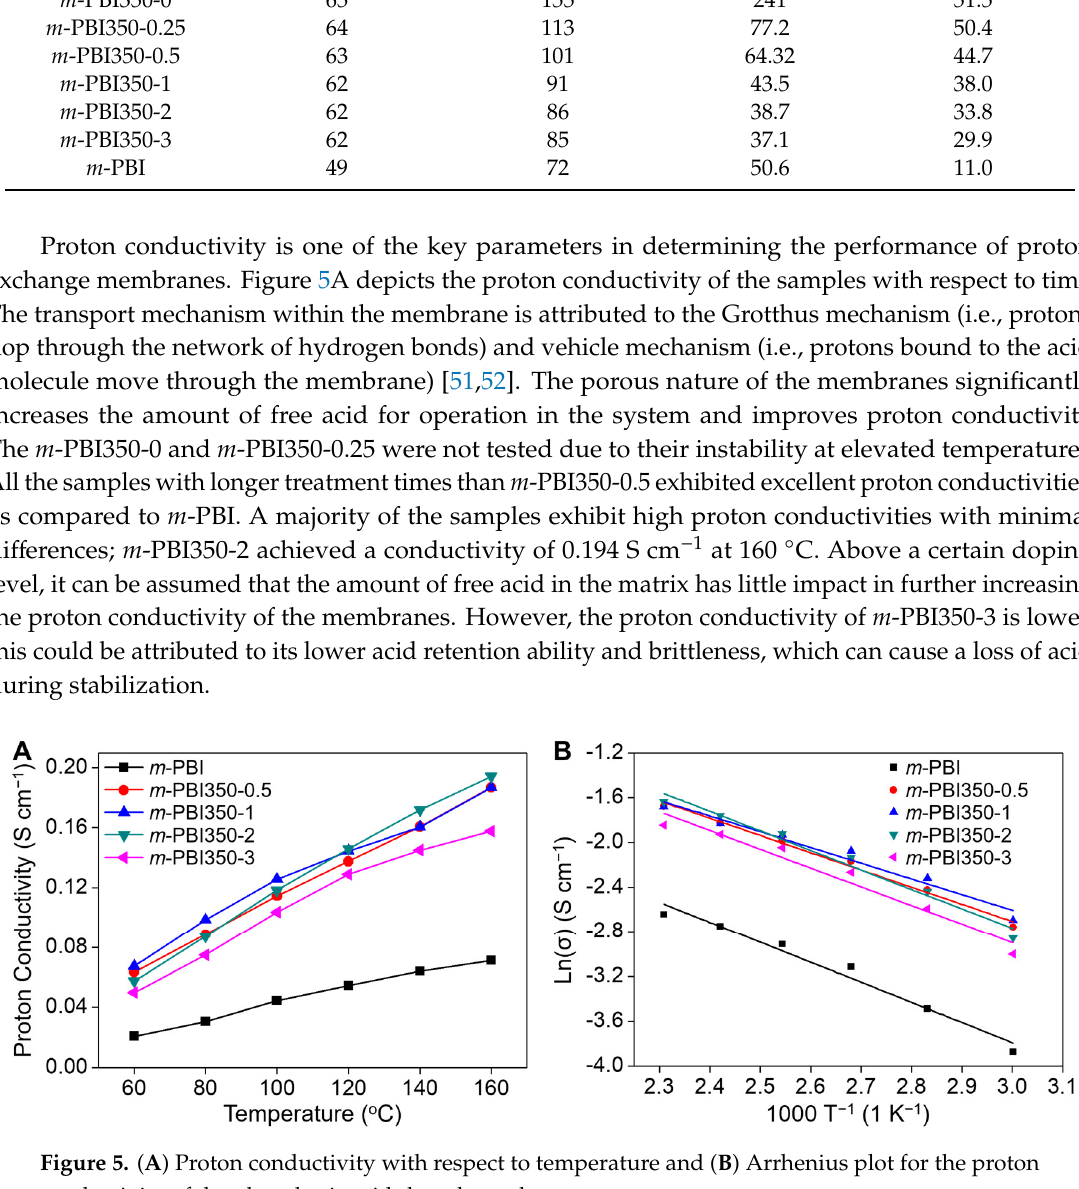
Figure 5. ( A ) Proton conductivity with respect to temperature and ( B ) Arrhenius plot for the proton conductivity of the phosphoric acid-doped membranes. conductivity of the phosphoric acid-doped